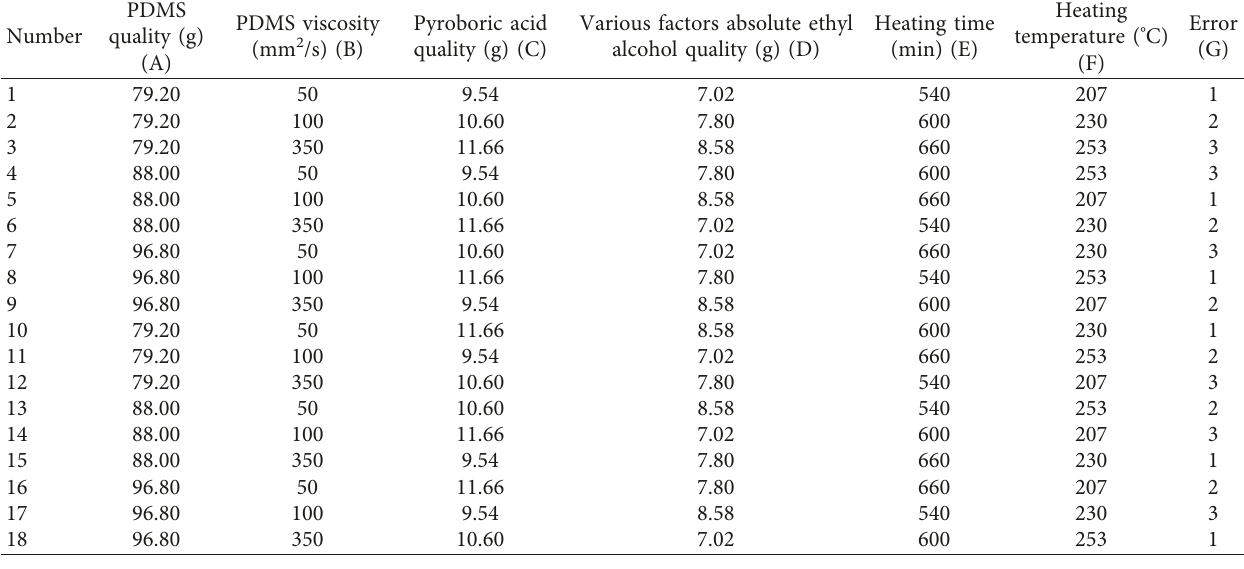
Table 2: The orthogonal table of each factor on the RSE of the matrix.